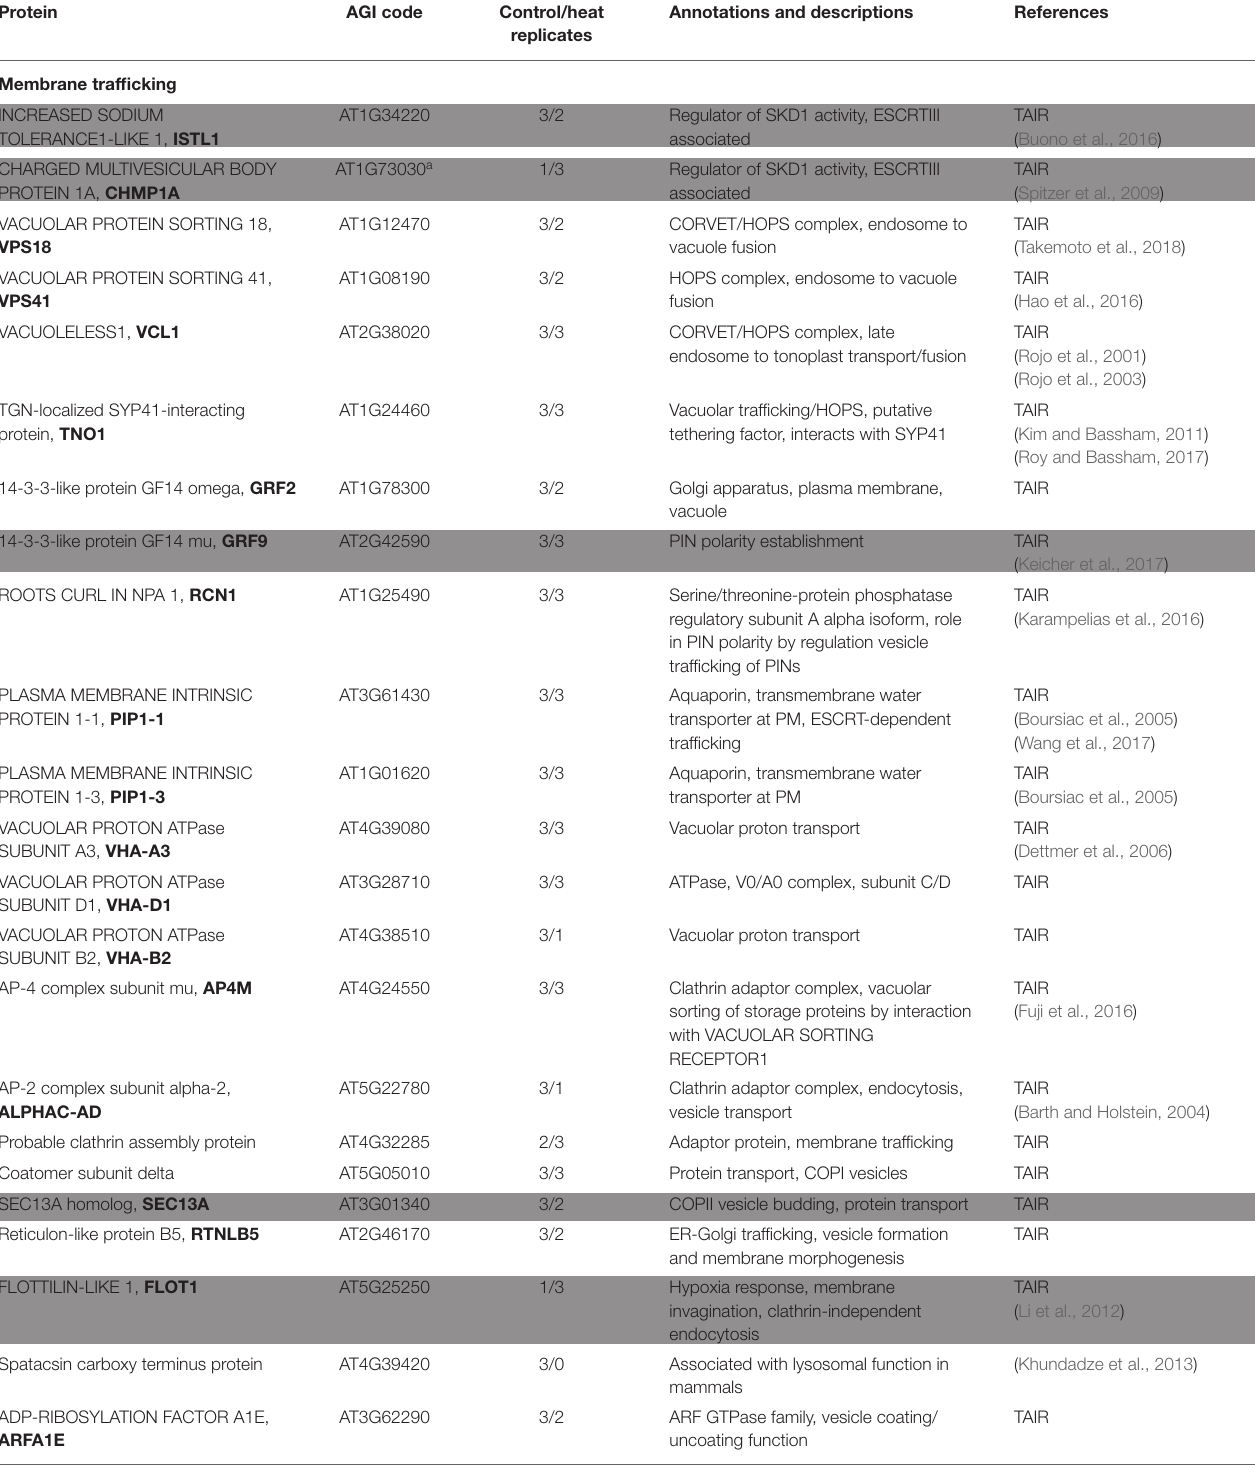
TABLE 2 | Proteins of the SKD1 interactome involved in membrane trafficking processes.